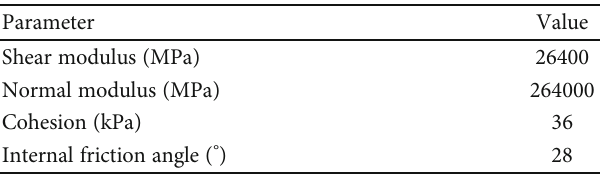
Table 3: Parameters for contact